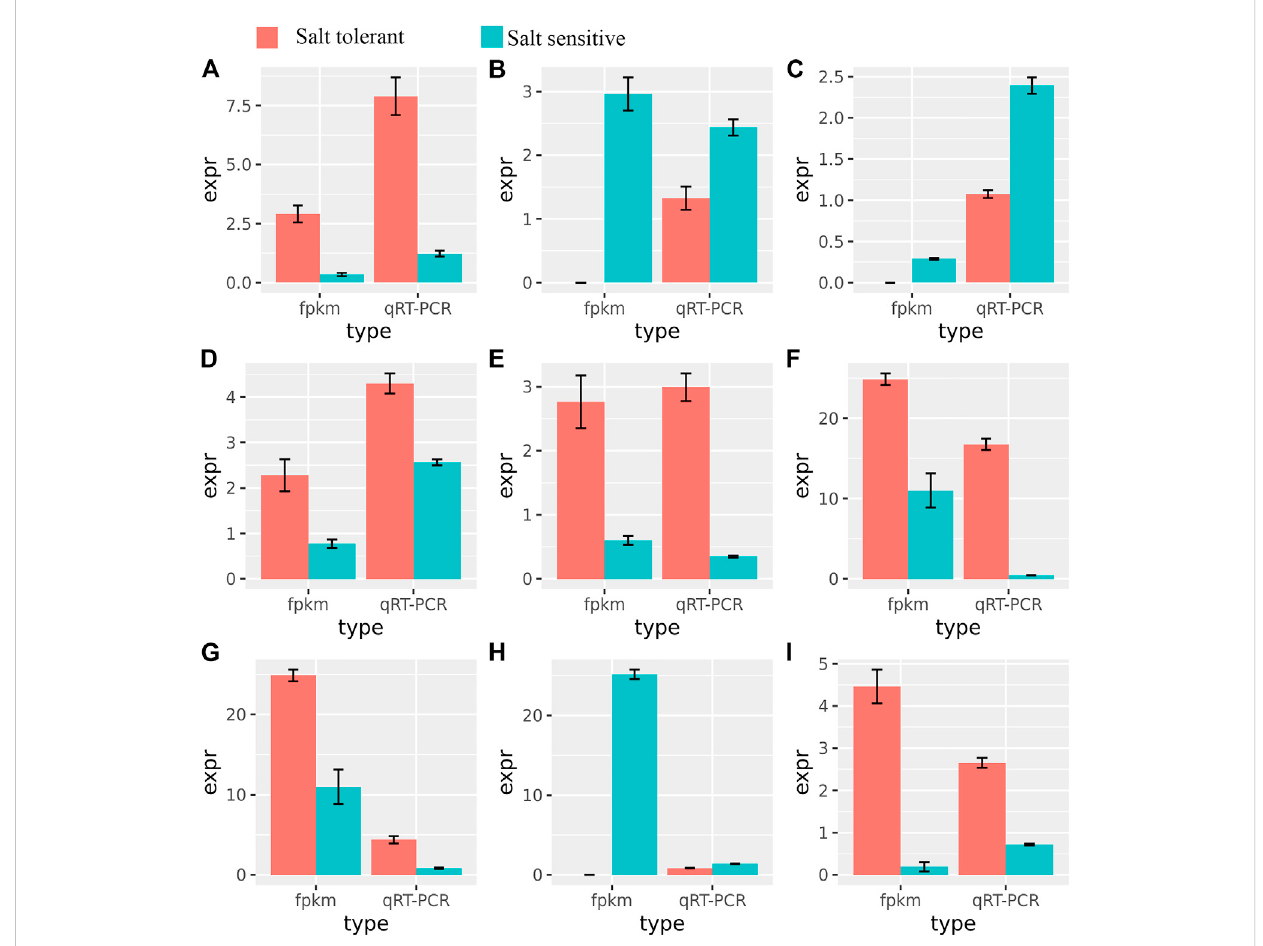
FIGURE 7 Relationships between FPMK and qRT-PCR validation of nine differentially expressed genes. The expression values (mean ± SE) were used in comparison to those of RNA-Seq. (A) : TraesCS6B02G205900; (B) : TraesCS5A02G391700; (C) : TraesCS5A02G391700; (D) : TraesCS4A02G425300; (E) : TraesCS5D02G452500; (F) : TraesCS2A02G483300; (G) : TraesCS5B02G449500; (H) : TraesCS2D02G567100; (I) :